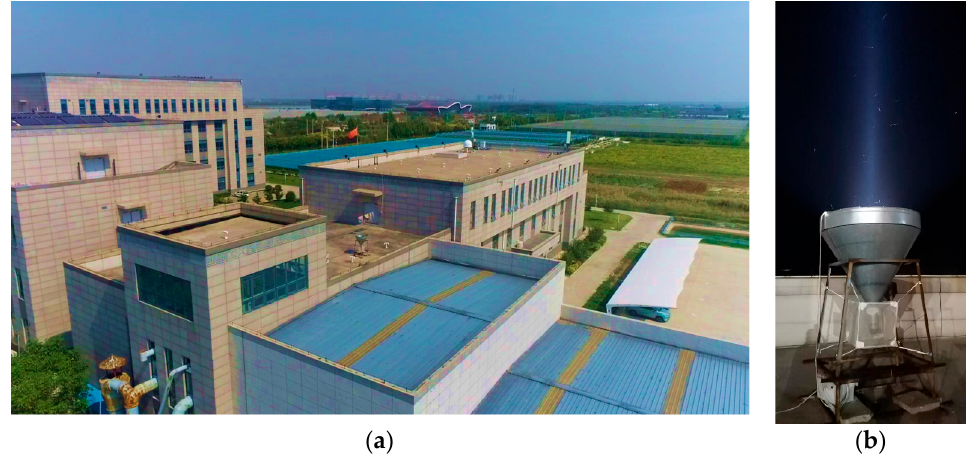
Figure 11. Searchlight trap. ( a ) Installation position. ( b ) Working scene.